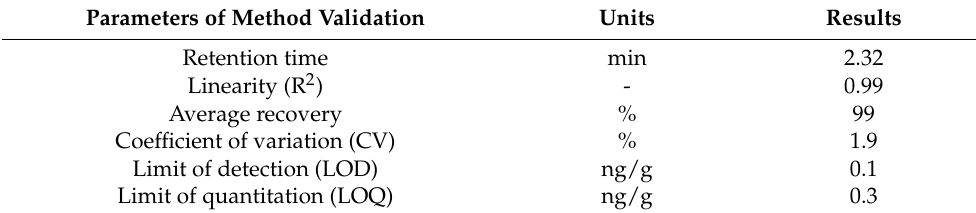
Table 1. Results of the analytical method validation of enrofloxacin in